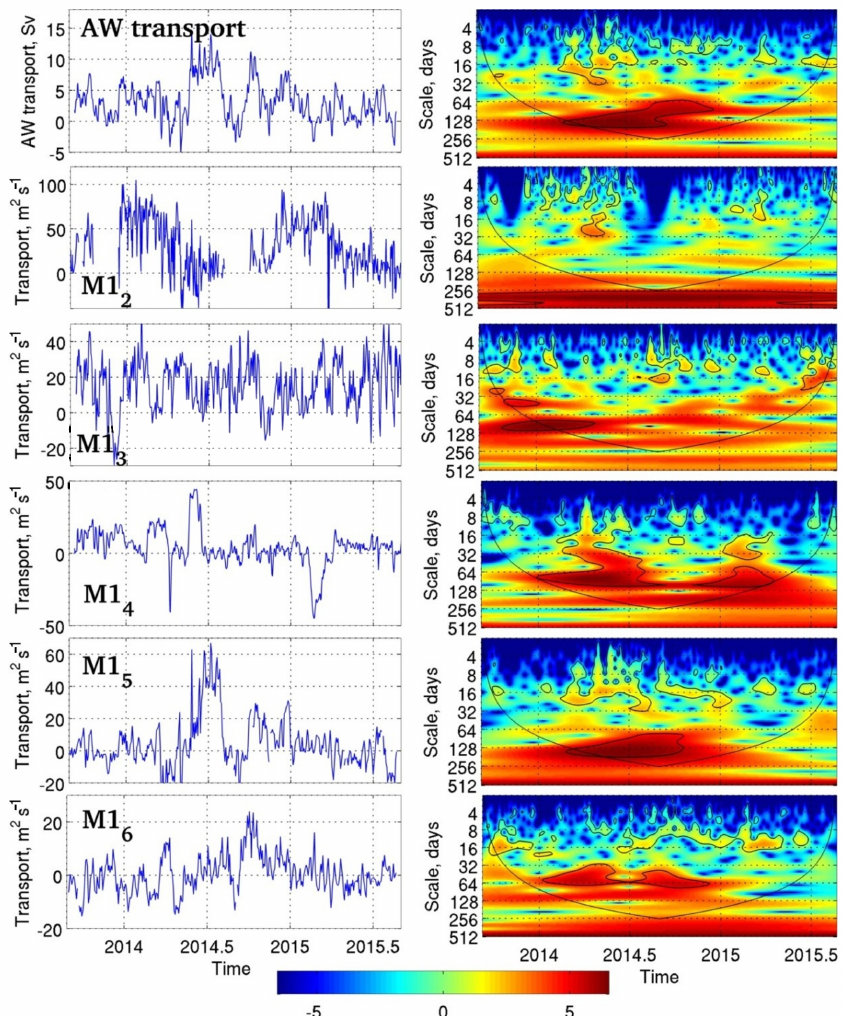
Figure 11. Depth-integrated AW transports at moorings, volume transport in the AW layer at the Laptev Sea slope, and their wavelet powers (in units of normalized variance). Scales indicate periods defined in wavelet spectral analysis. Black lines show significance at the 95% confidence level. Outside the cone of influence (black lines), the edge effect from finite series length becomes